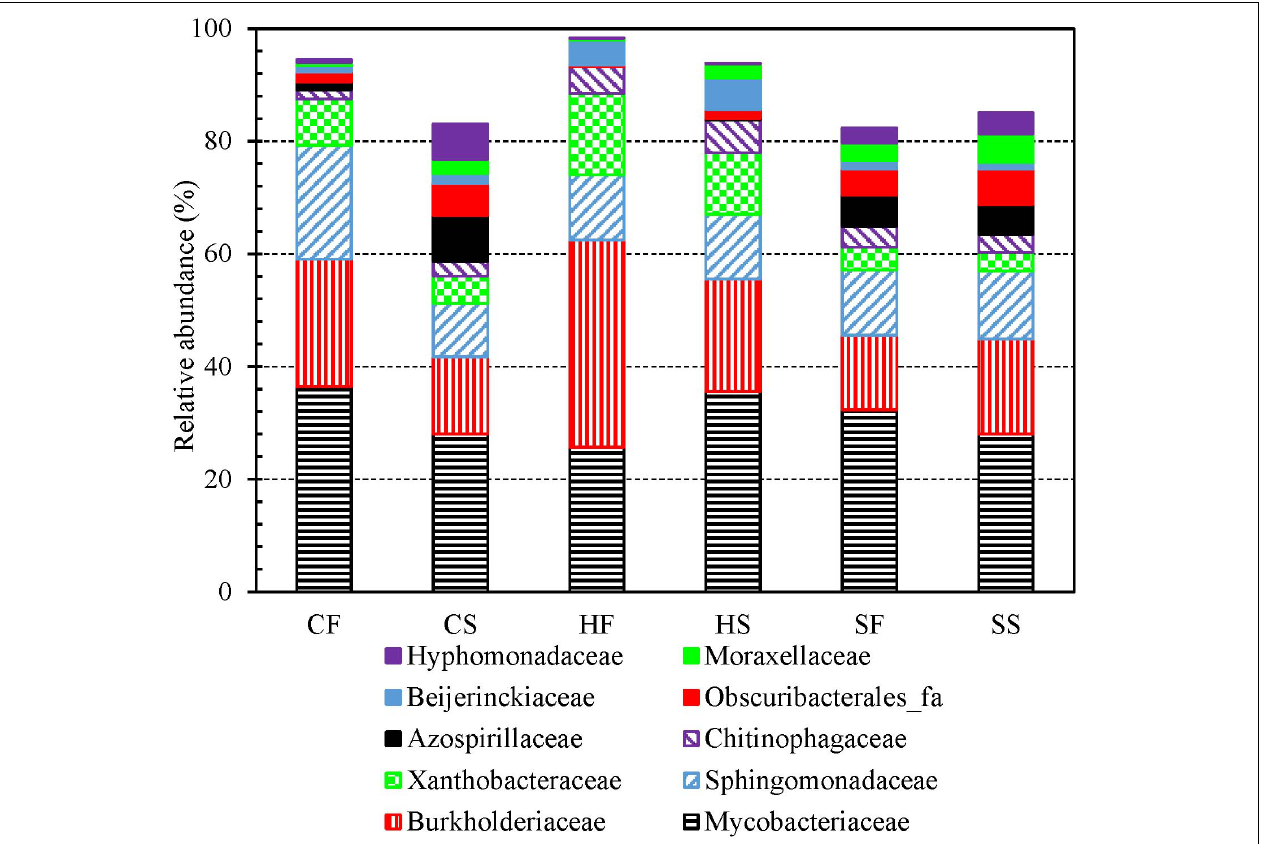
FIGURE 3 | The relative abundance of dominant bacterial families in the first and second draws of cold tap, hot tap, and shower water (six groups of water samples). CF : Cold tap water-First draw. CS : Cold tap water-Second draw. HF : Hot tap water-First draw. HS : Hot tap water-Second draw. SF : Shower water-First draw. SS : Shower water-Second draw. We assigned a family to each contig for each water sample with Mothur and then calculated the relative abundance of each family for each group of samples. We displayed a family only if its relative abundance is greater than 5.00% in at least one